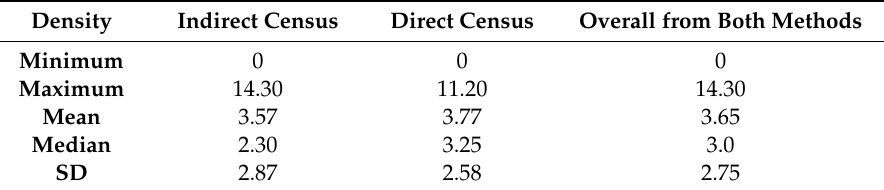
Table 2. Fox density (number of animals/km 2 ) estimated with direct and indirect monitoring during 2011 and 2012.